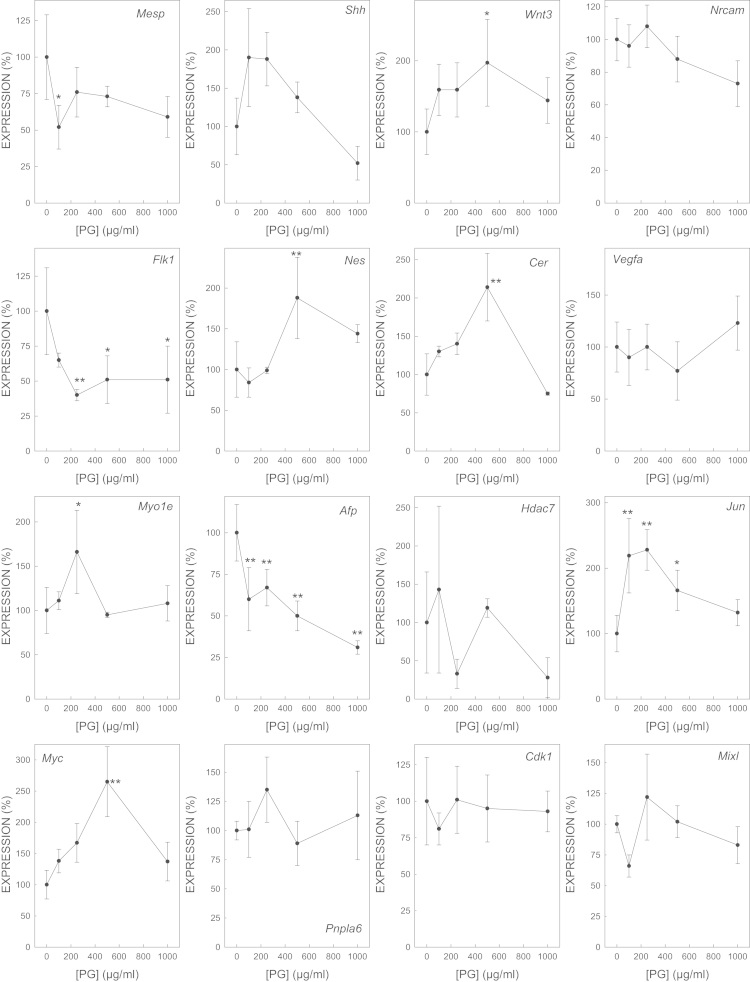
Effect of PG on the expression of biomarker genes.